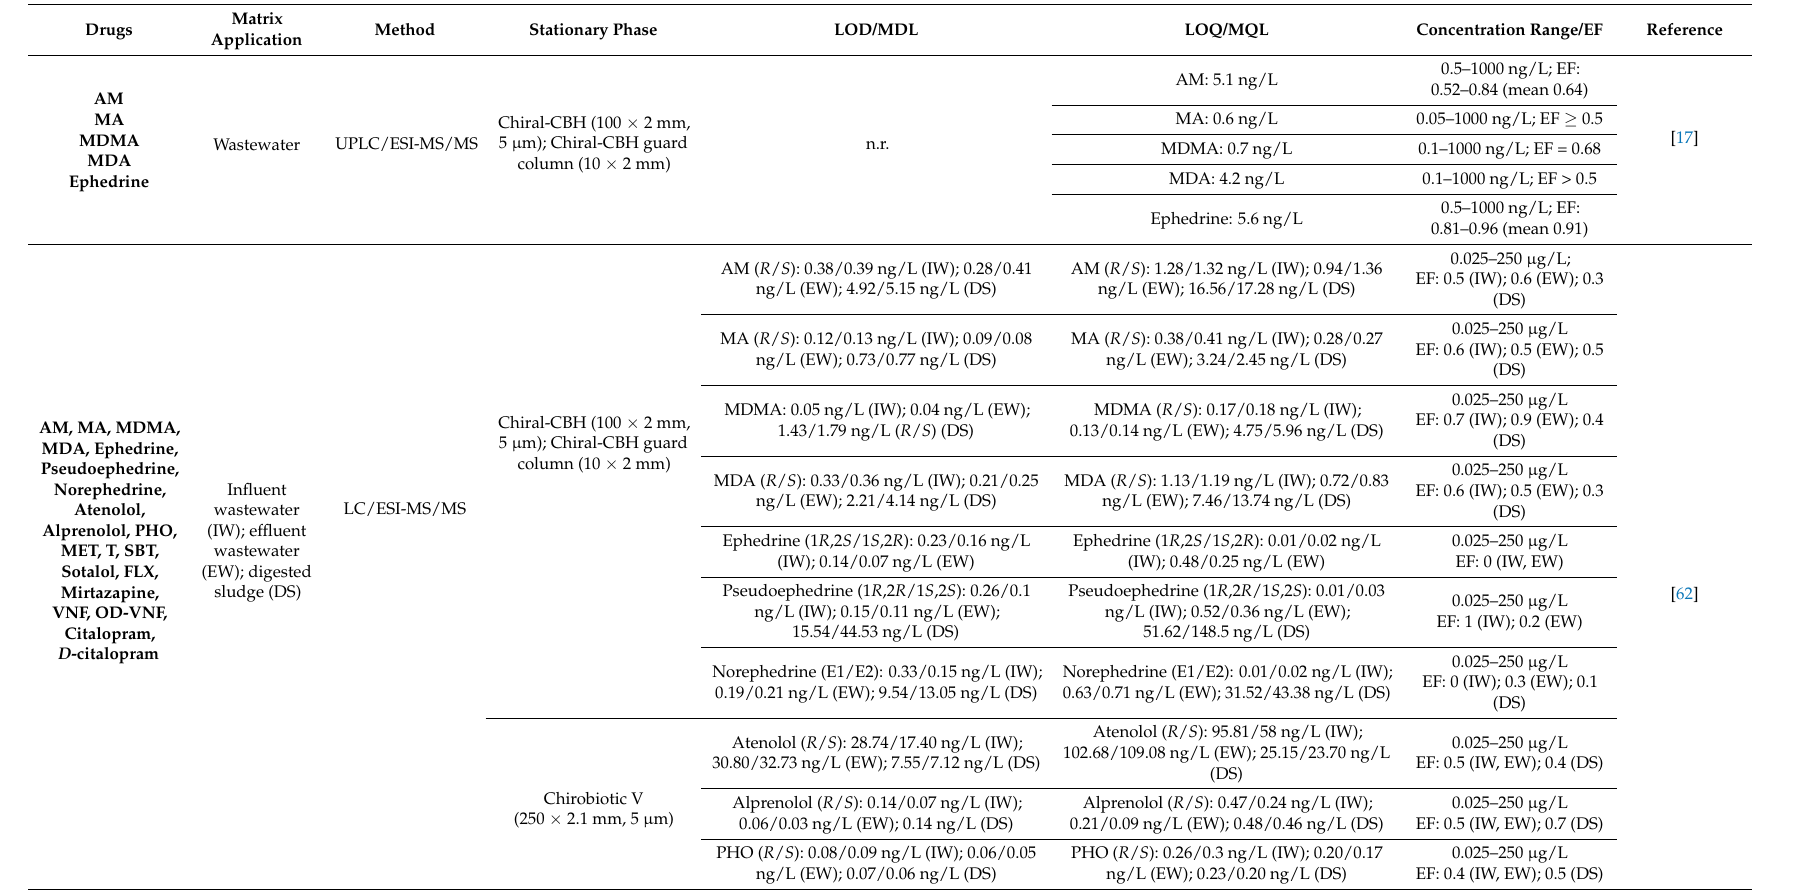
Table 3. Analytical methods of separation of several chiral illicit drugs and pharmaceuticals in different environmental